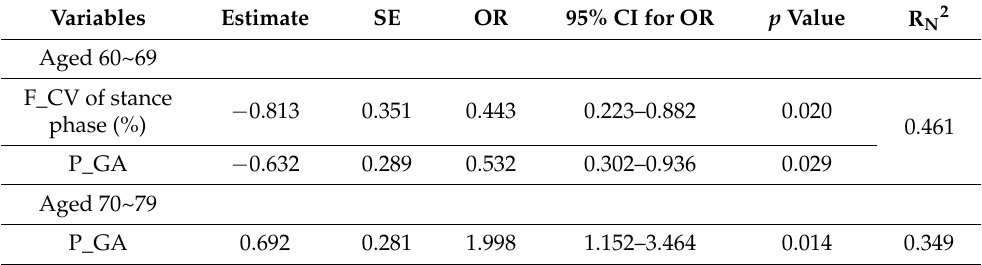
Table 4. Binary logistic regression results for males and